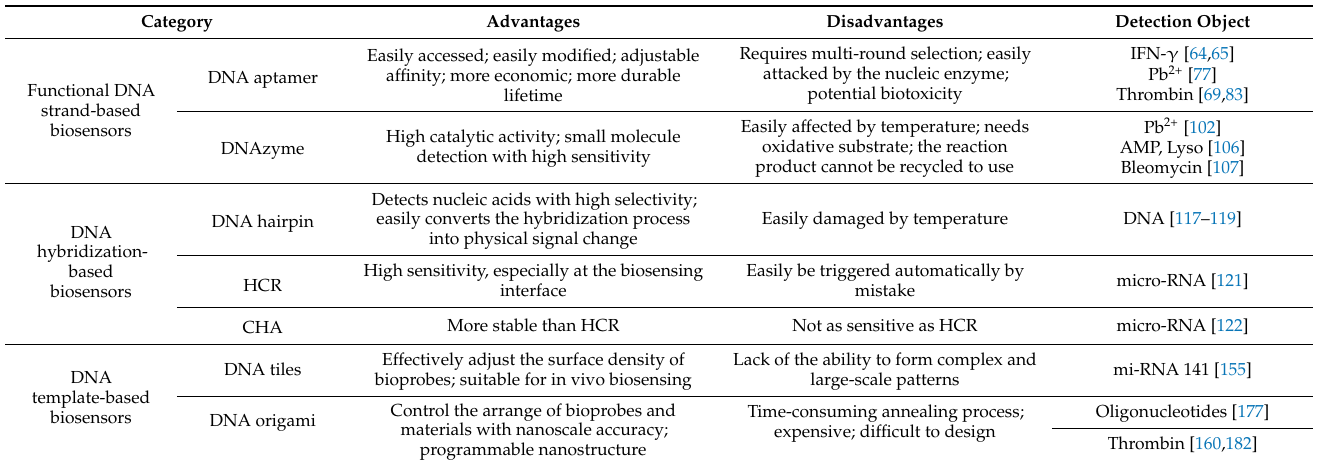
Table 1. Summary of the different types of DNA-based